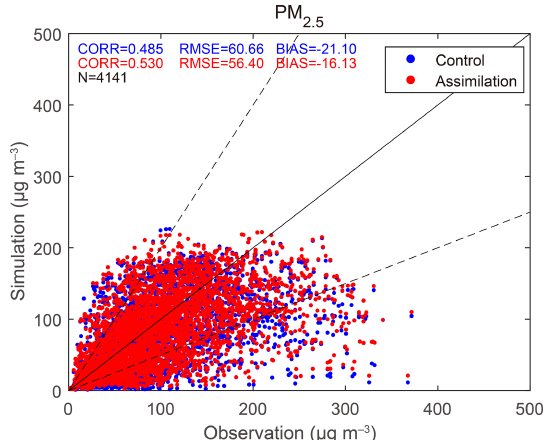
Figure 11. Scatter plots of the simulated PM 2 . 5 concentrations in the control experiment and corresponding analyses in the assimila- tion experiment vs. the observations. Like Fig. 7, these data are also colocated in D02 and a set of all initializations. Blue points stand for the control experiment, while red points stand for the assimilation